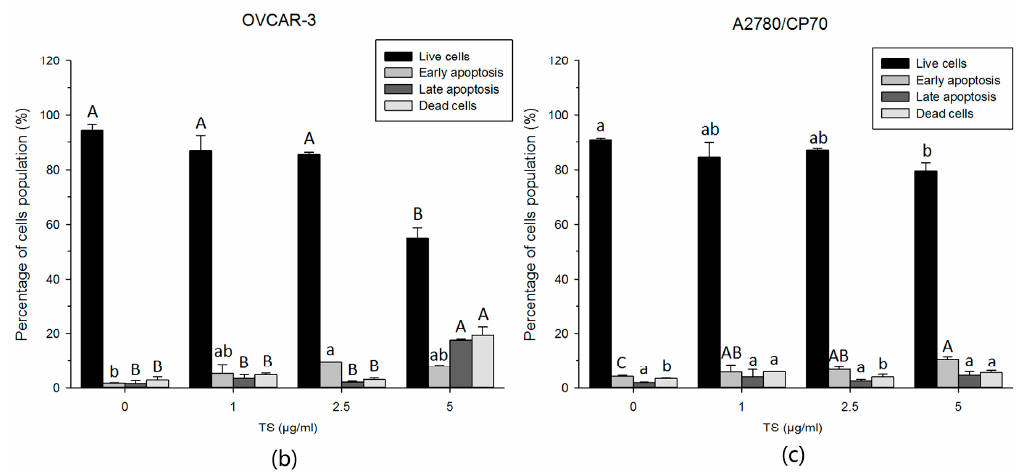
Figure 3. TS induces apoptosis in OVCAR-3 and A2780/CP70 cells. ( a ) Flow cytometry of TS treated OVCAR-3 and A2780/CP70 cells using a double staining method with FITC-conjugated Annexin V and PI. The upper left and lower left quadrant indicate the percentage of dead and live cells, respectively. The upper right and lower right quadrants indicate the percentage of late and early apoptotic cells, respectively; ( b ) Bar graphs showing the percentage of cell population of live cells, early apoptosis cells, late apoptosis cells and dead cells with treatment 0 to 5 µg/mL TS in OVCAR-3. ( c ) A2780/CP70. The capital letters (A, B, etc.) denote extremely significant differences among different